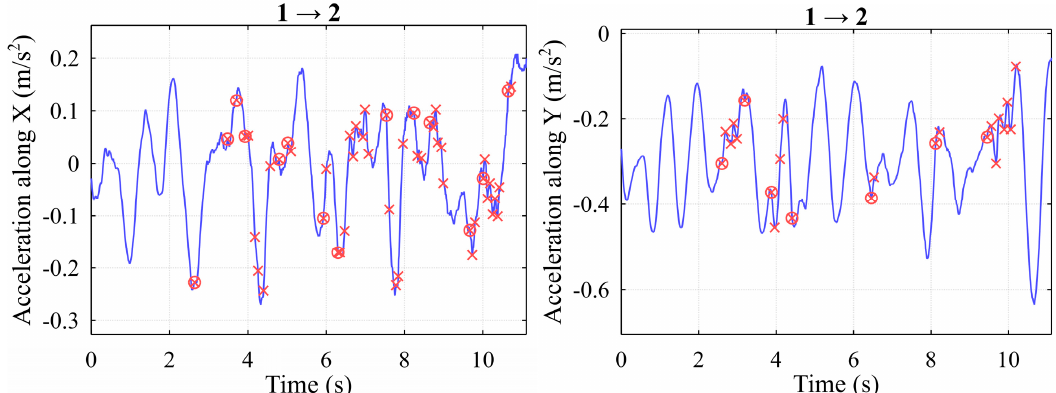
Figure 16. Use case No. 2 with the decreased threshold (detected impacts: ( left ) 14; ( right ) 7). A 10% decrease resulted in the diminished number of impact detections along the X-axis, from 16 up to ten (Figure 17), and the number of impacts along the Y-axis remained the